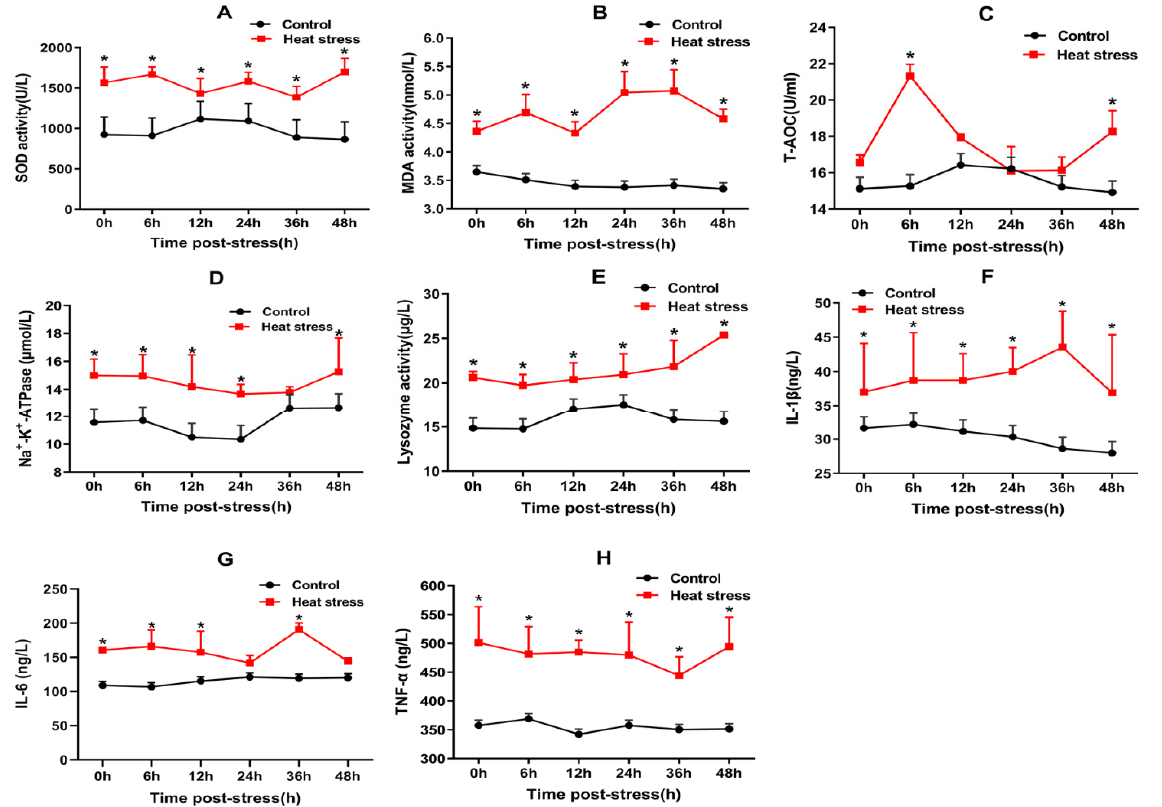
Figure Figure 1. Physiological and biochemical indices of rainbow trout under acute heat stress. ( A – D ) represent the levels of antioxidant factors SOD, MDA, T-AOC, and Na + -K + -ATPase in the serum of rainbow trout under 22.5 °C for 48 h (n = 6, *, p < 0.05). ( E – H ) represent the levels of inflammatory cytokines lysozyme, IL-1 β , IL-6, and TNF- α in the serum of rainbow trout under 22.5 °C for 48 h (n = 6, *, p < 0.05).